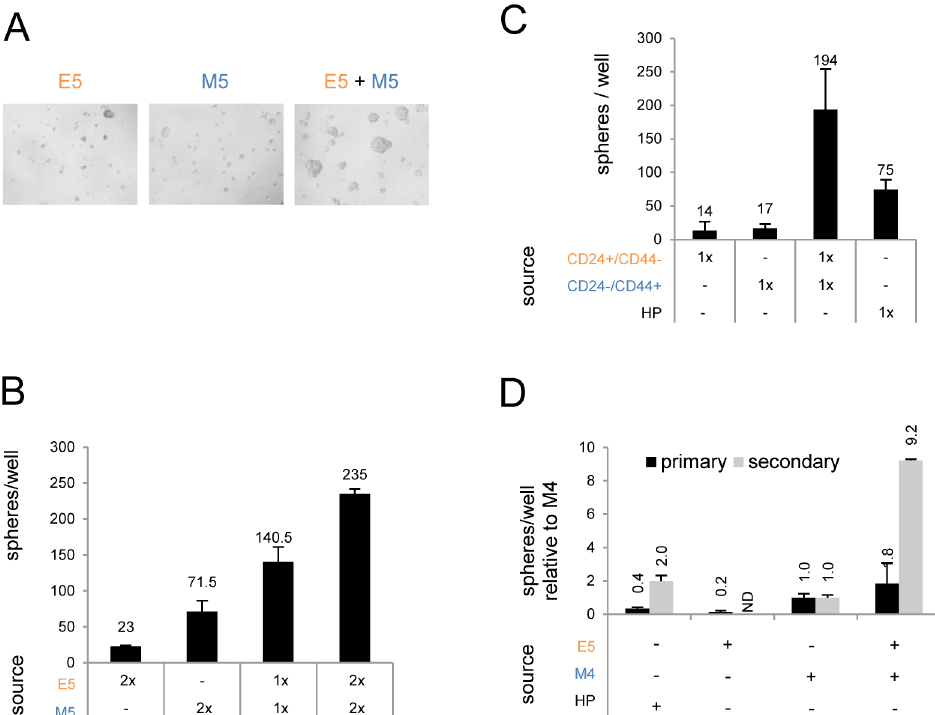
Fig 4. Co-culture of E and M cell-types synergistically increases mammosphere formation. (A) Representative light microscope images (10x objective) from mammospheres of 500 E5, 500 M5, and 500 E5 + 500 M5-derived mammospheres after two weeks suspension culture. (B) Total number of primary mammospheres derived from 500 (1x) or 1000 (2x) cells per cell-type seeded (from A) after two weeks suspension culture. (C) Total number of primary mammospheres grown from 500 (1x) freshly sorted CD24+/CD44-(E) cells, 500 CD24-/CD44+(M) cells, the co-culture, or 500 un-gated HP cells ( ‘ all HP ’ ) after two weeks of mammosphere formation. (D) Relative number of primary (seeded 2,000 cells per cell line per well) and secondary mammospheres from M4 grown with or without E5 cells or HP cells. After two weeks 10% of total number of dissociated cells from the indicated primary mammosphere samples were reseeded for secondary mammospheres and counted after one week. Mammospheres per well relative to that of M4-derived spheres are